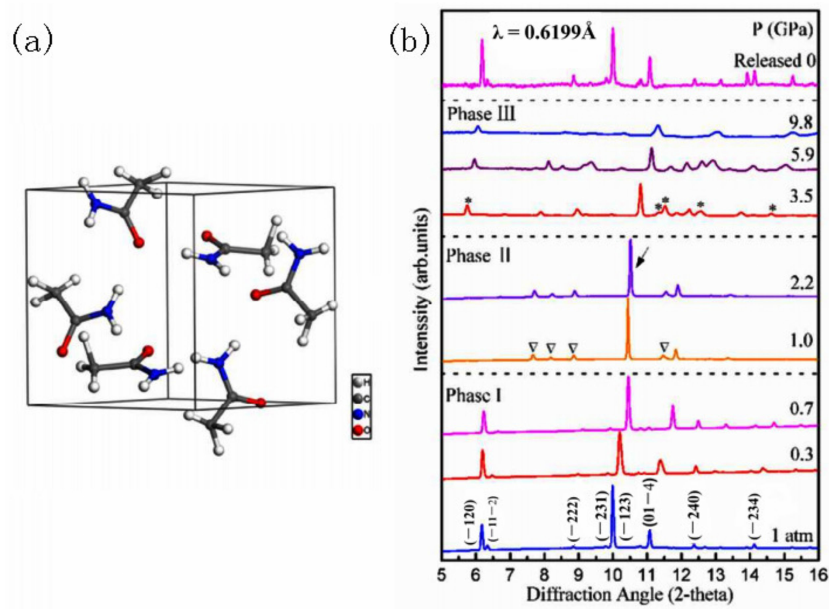
Figure 4. Ambient unit cell ( a ) and representative ADXRD patterns of acetamide crystal at different pressures ( b ). The peaks marked by asterisks and hollow triangles indicate the emergences of new phases. Reprinted with permission from Ref. [74] Copyright 2013 Royal Society of